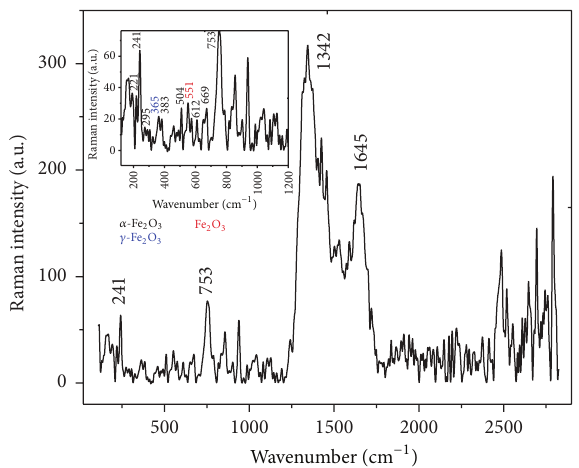
Figure 4: Raman spectrum of the 𝛼 -Fe 2 O 3 -Ag bimetallic